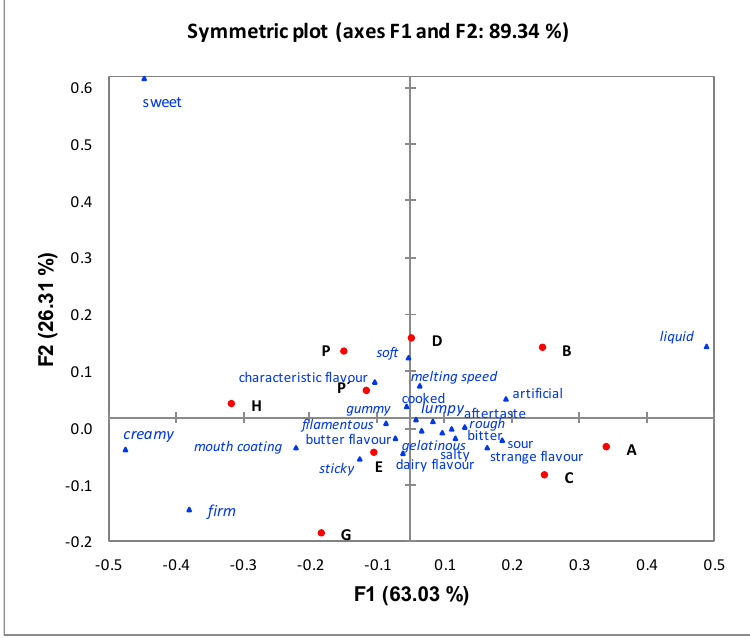
Figure 2. Representation of the samples and attributes in the first two factors of the correspondence analysis of sensory data obtained using PP + CATA. Texture attributes are shown in italics and flavour attributes in regular type.